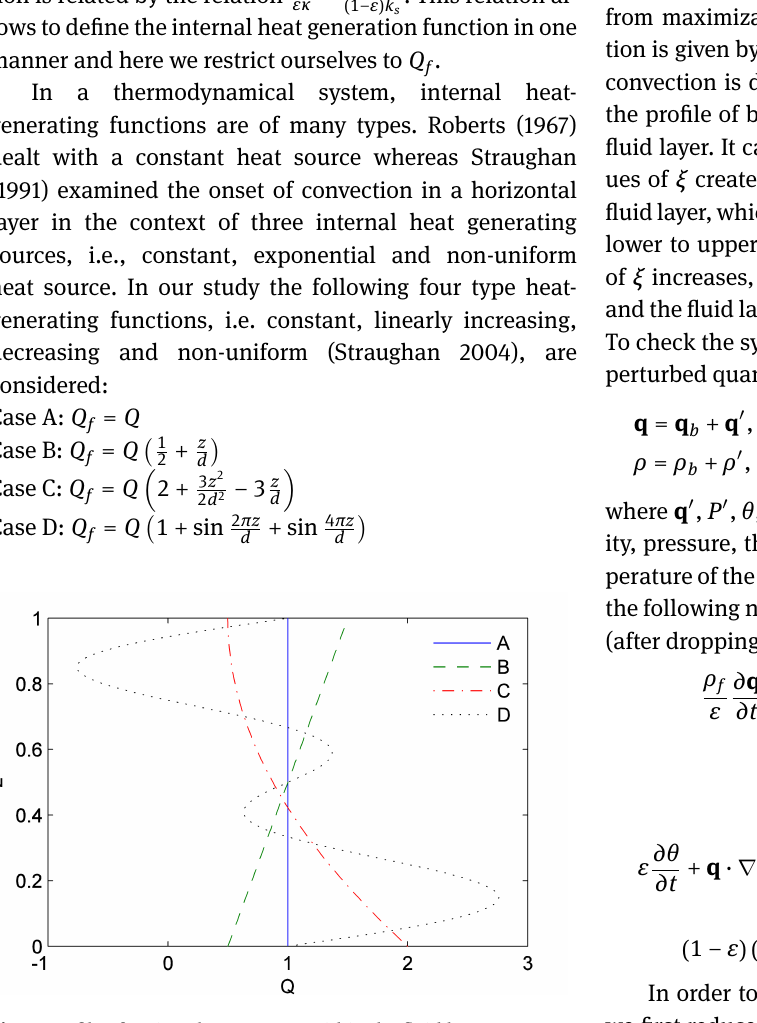
Fig. 1: Profile of various heat sources within the fluid